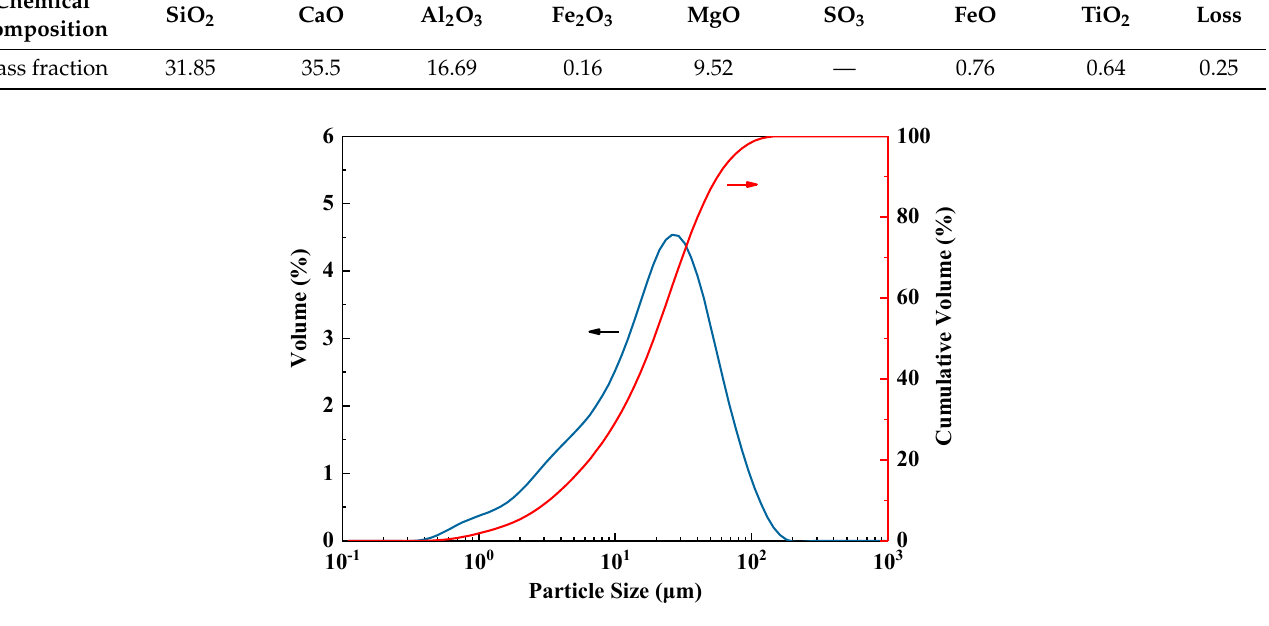
Figure 1. Particle size distribution of GGBS.